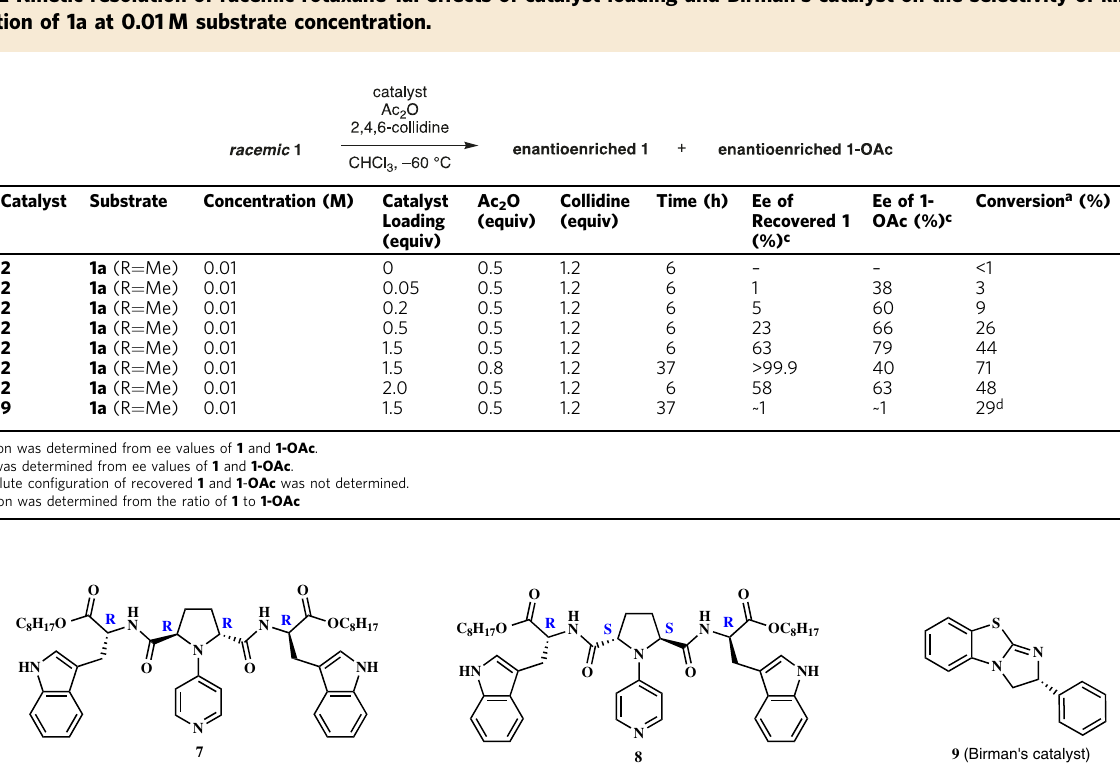
Fig. 3 Structure of catalysts. Catalysts 7 and 8 are the analogues of catalysts 2 and 3 with different side chains for substrate recognition. Birman ’ s catalyst 9 is a representative catalyst for acylative kinetic resolution of racemic alcohols.